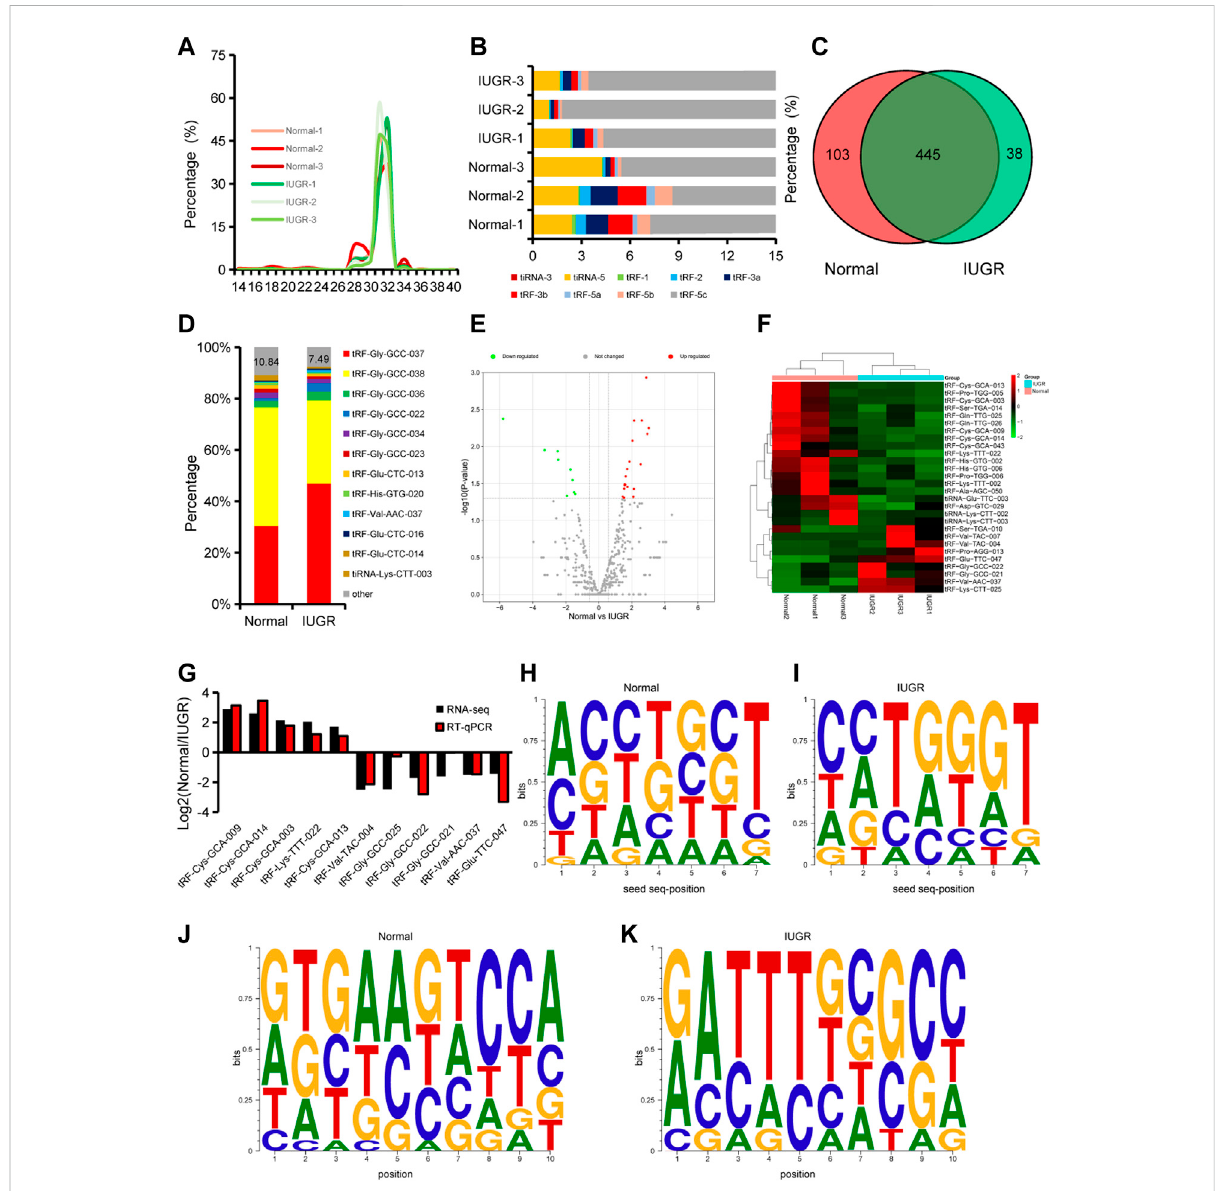
Expression dynamics of tsRNAs in porcine skeletal muscle. (A) Size distribution of microRNAs. (B) Types and distribution of tRNA-derived small RNAs (tsRNAs). (C) Venn diagrams with the number of expressed tsRNAs. (D) Composition of the top ten most expressed tsRNAs. (E) Volcano plot of differentially expressed tsRNAs. (F) Heatmap and clustering of differentially expressed tsRNAs. (G) Expression dynamics of selected tsRNAs by RT- qPCR. Results of at least three replicates ( n = 3). (H,I) Characterization of seed sequences of differentially expressed tsRNAs highly expressed in normal-size pigs (H) and in intrauterine growth restriction (IUGR) pigs (I) . (J,K) Characterization of 3 ′ -end sequences of differentially expressed tsRNAs. (H – K) , The size of the letter indicates the frequency of the